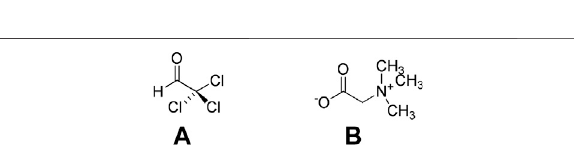
FIGURE 9 | Molecular structures of chloral and